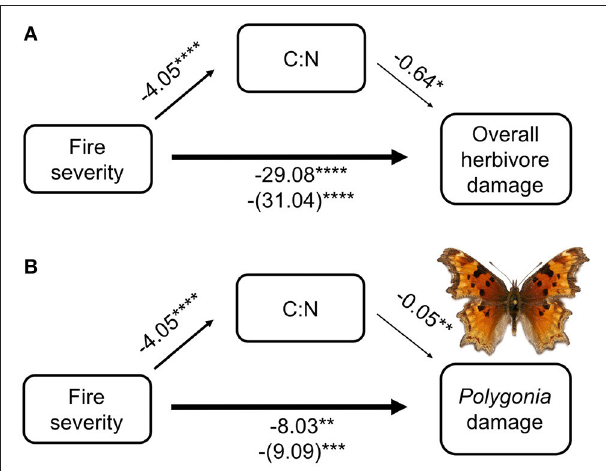
FIGURE 5 | Mediation analysis of fire severity, C:N ratio, and herbivore damage on wax currant plants for (A) overall herbivore damage and (B) herbivore damage by Polygonia gracilis zephyrus . Numbers are model coefficients (coefficients in parentheses are the model that considers both C:N and fire severity) and asterisks indicate significant effects at * p < 0.05, ** p < 0.01, *** p < 0.001, **** p < 0.0001.